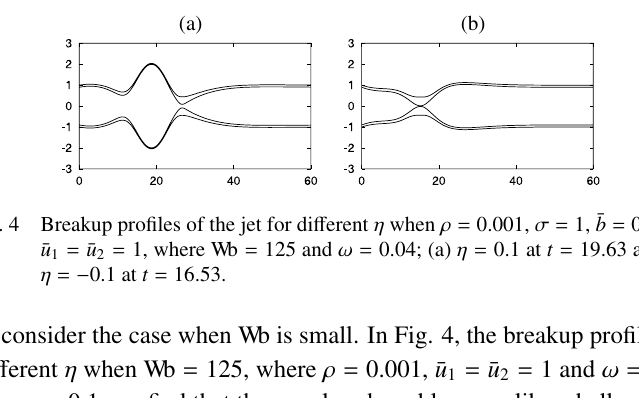
= 1 and ¯ u = 0 at t = 12 . 9. 1 2